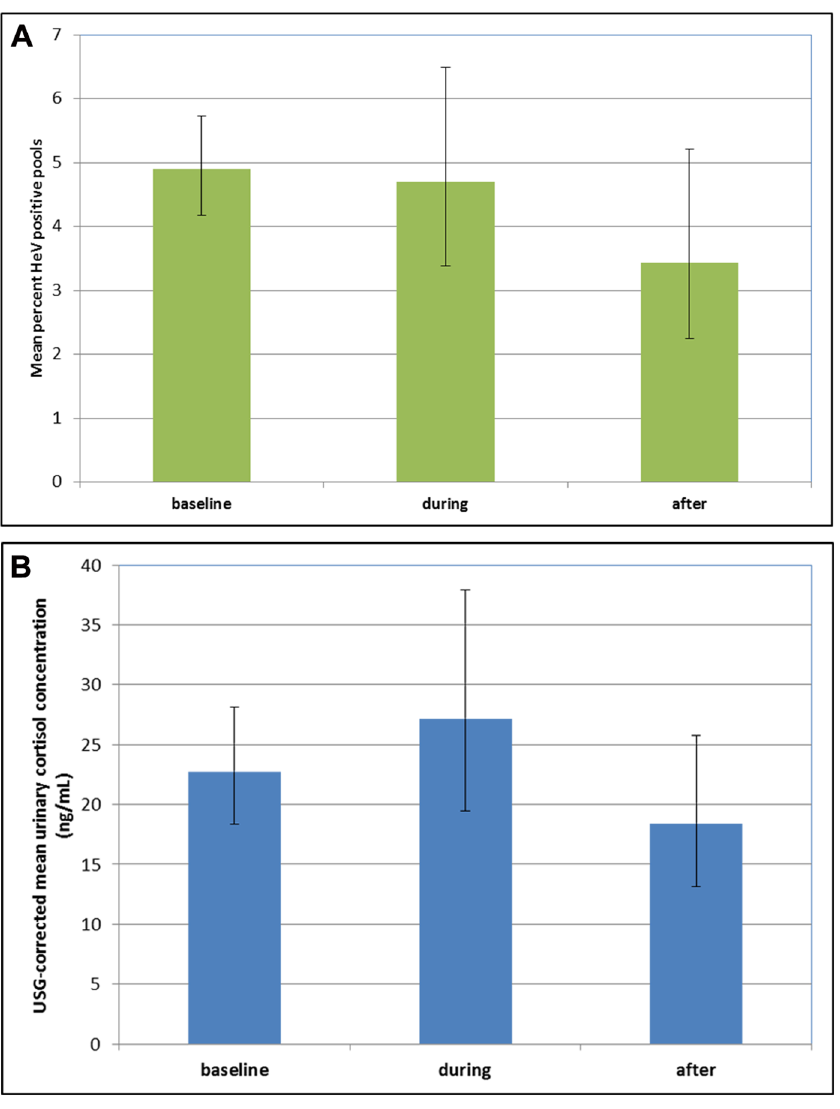
Fig 3. Adjusted overall effect of roost disturbance on the prevalence of HeV (A) and on USG-corrected cortisol concentration (B) in pooled urine samples from flying-foxes roosts in the eastern Australian states of Queensland and New South Wales between September 2011 and November 2012. Error bars represent the mean ± one standard error, obtained by back-transforming variance from the logistic scale. samples within dates. The difference in overall mean HeV prevalence before (4.9%), during (4.7%) and after (3.4%) disturbance was small and non-significant (P = 0.440, Fig 3A). Similarly, the difference in overall mean USG-corrected cortisol concentrations was small and non-significant (before disturbance = 22.71 ng/mL, during disturbance = 27.17, after distur- bance = 18.39) (P = 0.550, Fig 3B). The effect of disturbance on cortisol concentration ap- = 1.80, P = 0.108). No other two-way proached statistical significance for region (F 7, 52 interactions appeared important across various alternate models (data not shown). USG- = 3.91, P = 0.014) and corrected cortisol concentration varied significantly with season (F 3, 50 = 4.18, P < 0.001), with winter levels (34.78 ng/mL) higher than in summer with region (F 15, 50